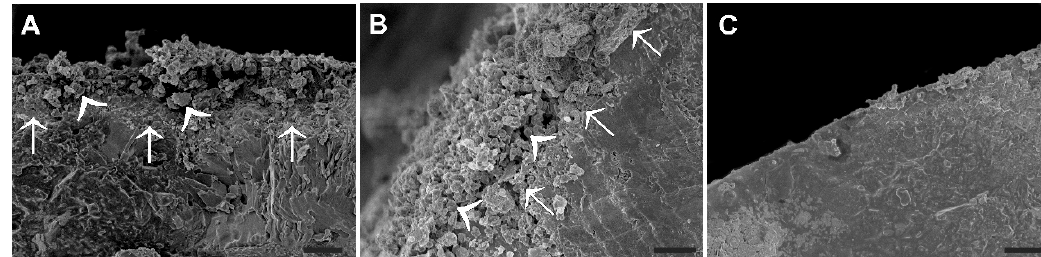
Figure 1. Scanning electron micrographs showing cross sections of fertilizer granules with ( A , B ) and without ( C ) an outer layer of sulphur crystals. ( A ) Cross-section of ES coated fertilizer granules containing sulphur crystals of different size (arrowheads) in the outer layer, attached to granule with a binder layer (arrows). ( B ) A bending view of the ES coated fertilizer bead, providing in addition an extended view of its surface covered by ES powder. ( C ) Control granules are characterized by a sharply defined edge without an outer layer. Bars=20 μ m.